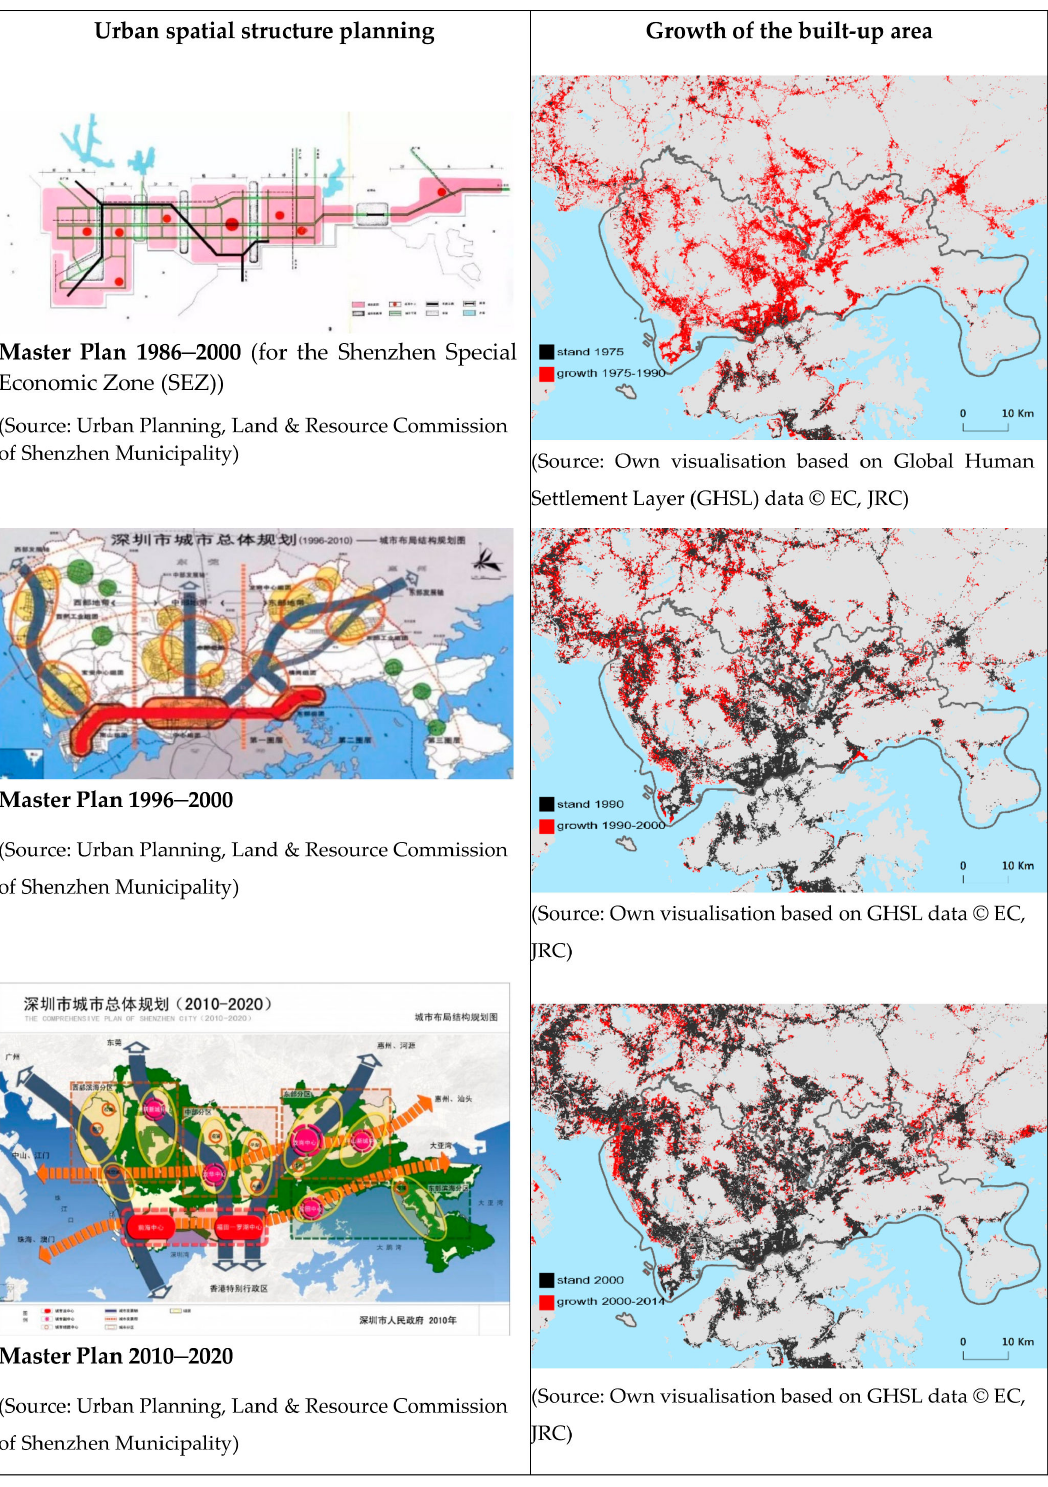
Figure 3. The urban spatial structures foreseen by selected master plans and the growth of built-up areas in the corresponding time periods in